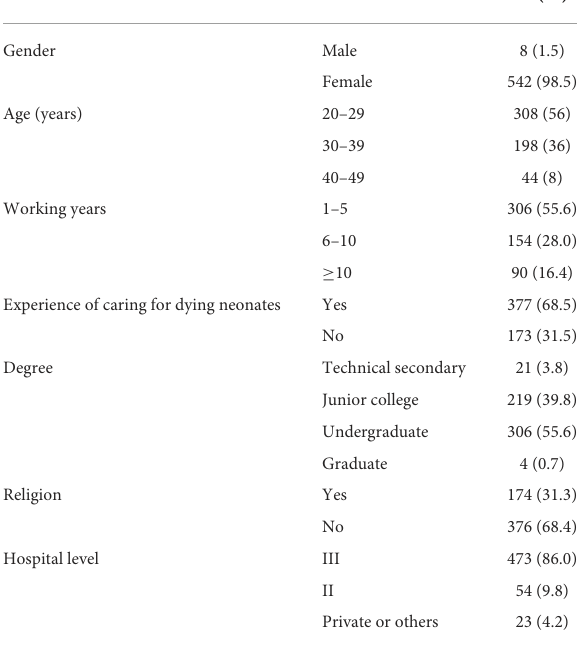
TABLE 1 Personal characteristics ( N = 550)